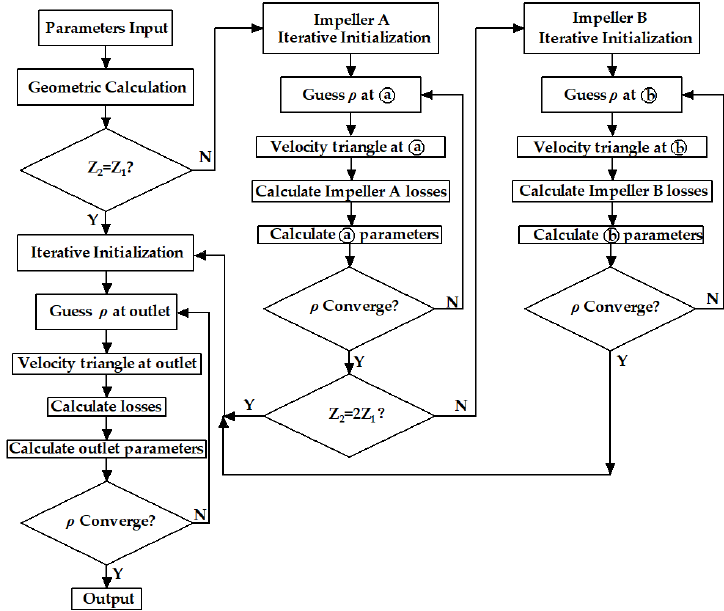
Figure 4. Aerodynamic calculation process for an impeller with splitter blades.